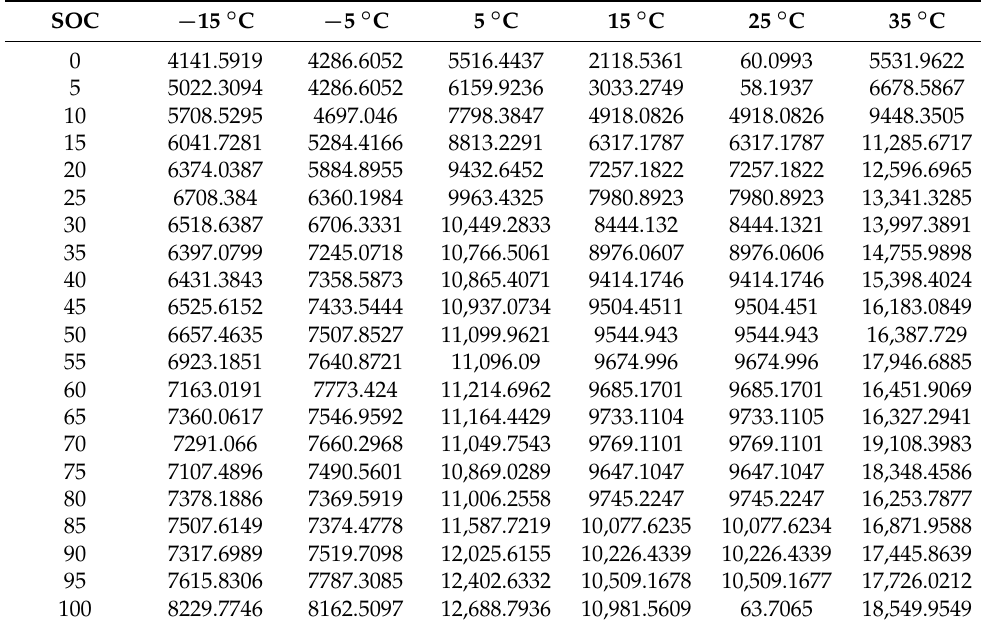
Table A2. Values for parameter C 2 in F of electrical model shown in Figure 2 in dependence of cell temperature and SOC.